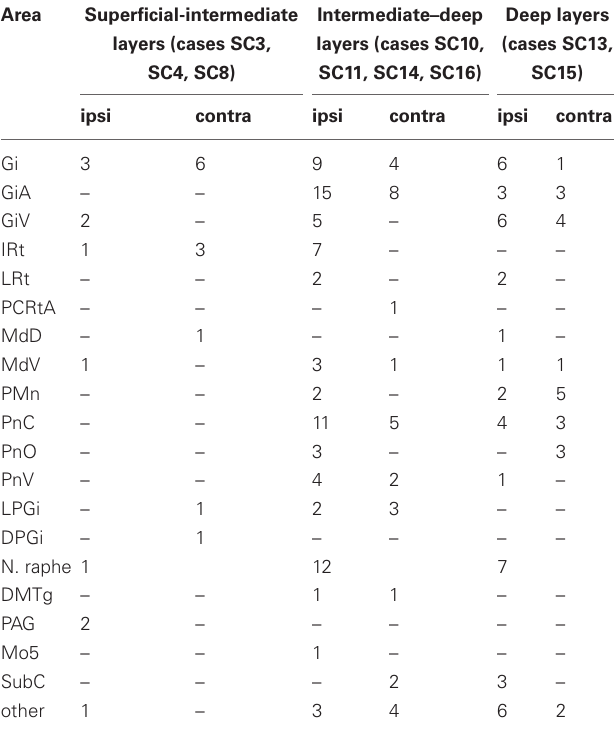
Table 1 | Summarized location of labeled neurons with neighboring varicosities ipsi- and contralateral to the SC injection site. Area Superficial-intermediate Intermediate–deep Deep layers